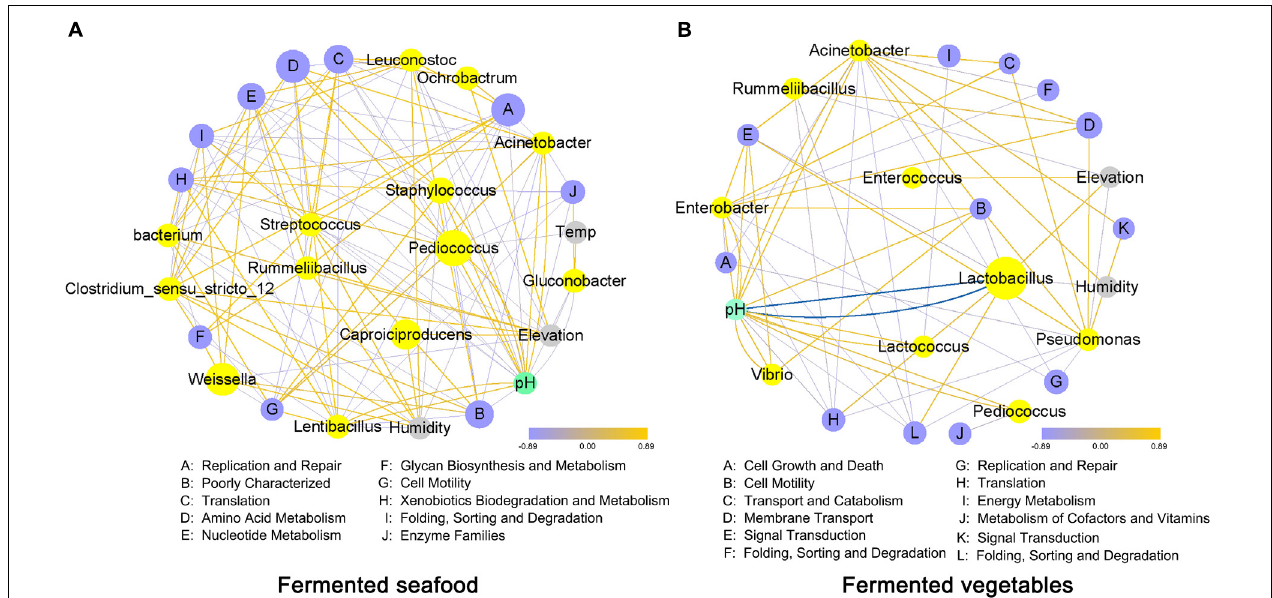
FIGURE 5 | Correlation analysis of climatic conditions, bacterial genera, metabolic pathways and pH value in fermented seafood (A) and fermented vegetables (B) ; correlation analysis was conducted by using the Spearman method, and the network was drawn with Cytoscape software. Data with an r value greater than 0.4 or r value less than –0.4 were selected. The color of the line connecting the different points indicates positive and negative correlations; the red line represents a positive correlation, and the blue line represents a negative correlation. The degree of thickness of the line shows the strength of the correlation, and the size of the points indicates the relative content.